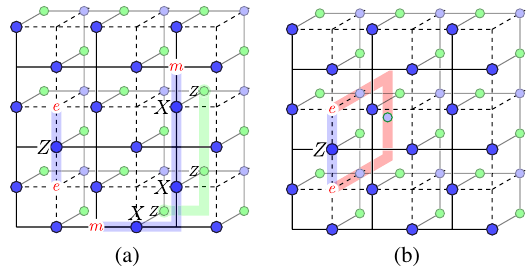
FIG. 6. (a) The e - and m -type excitations on the boundary of string and dual-string operators. For an e excitation ( m excitation) to be symmetric, they must be accompanied by a bulk dual- (primal-) string excitation terminating on them. (b) An example of a symmetric excitation. Two e excitations live on the boundary of a bulk dual-string excitation depicted in